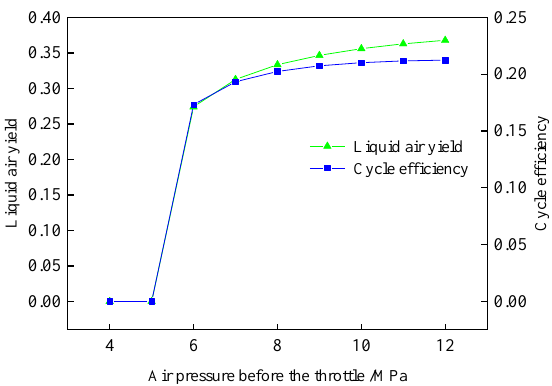
Figure 7. Influence of pressure before air throttling on liquid air yield ratio and cycle efficiency.